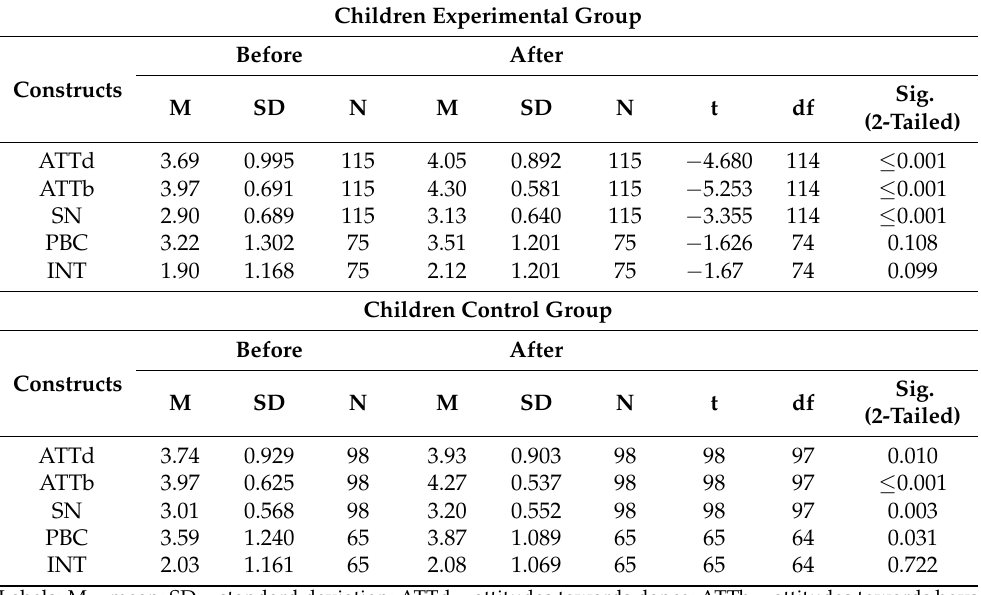
Table 3. Paired samples’ test results of children and adolescents: differences before and after the SMI—children. Children Experimental